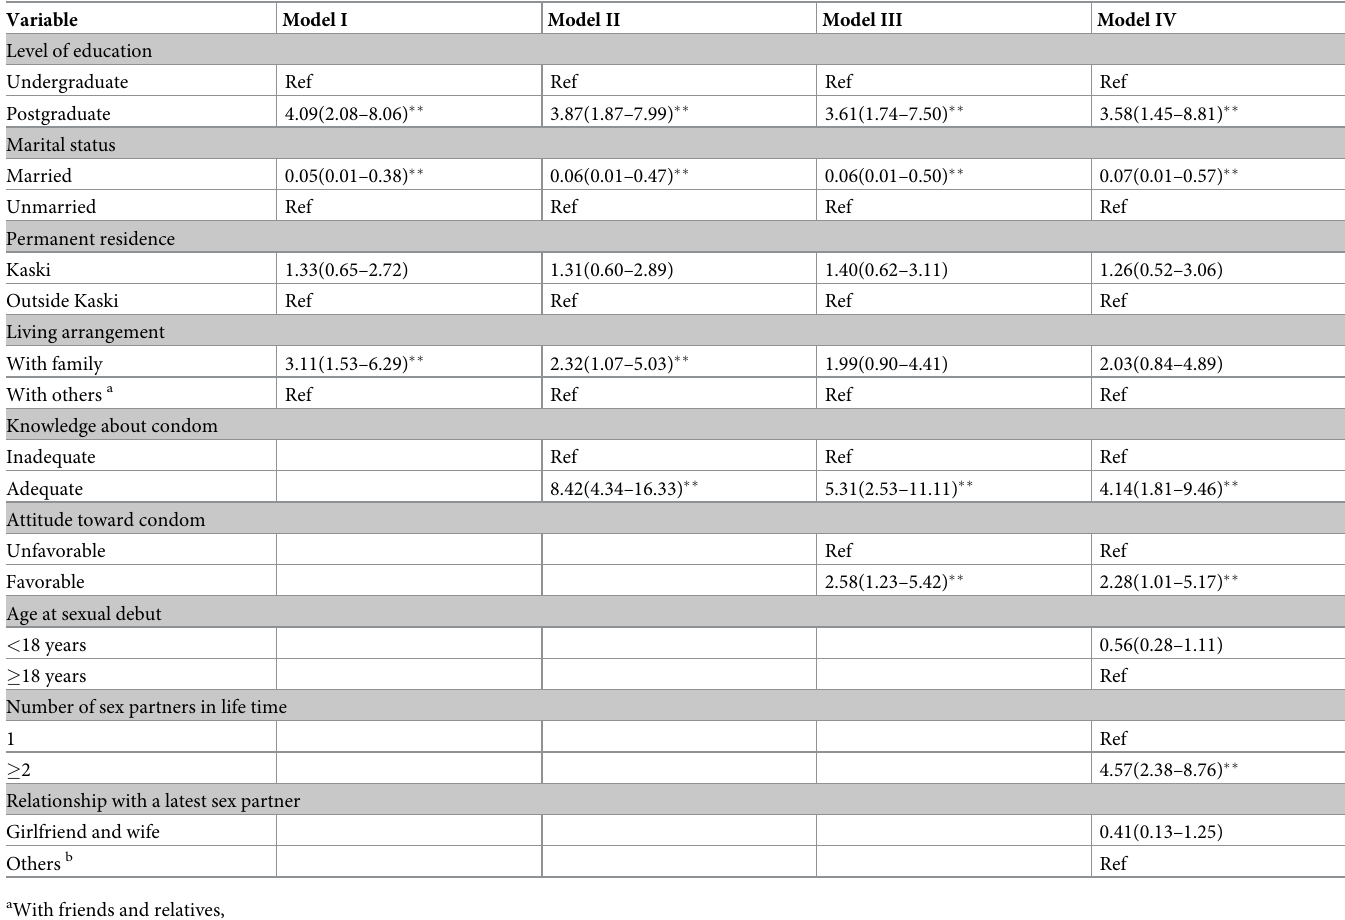
Table 7. Adjusted odds ratio to examine the strength of association between condom use during last sexual intercourse and related variable (n =